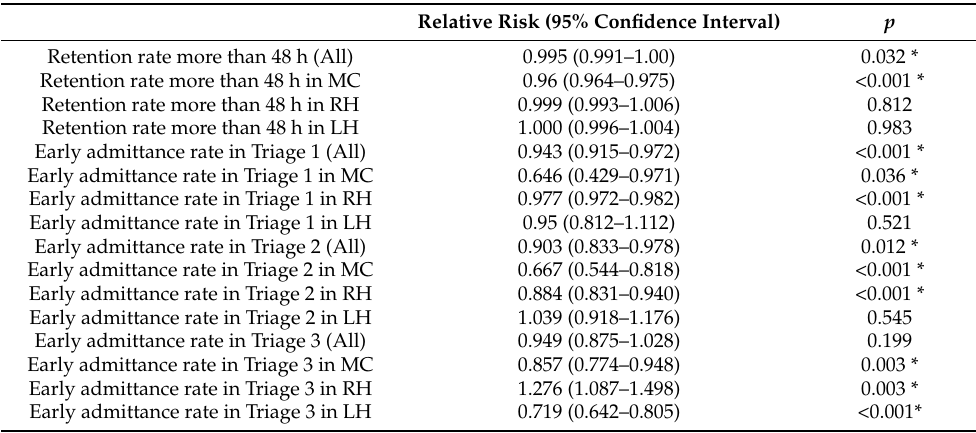
Table 4. The effect of healthcare quality in emergency department after MediCloud system